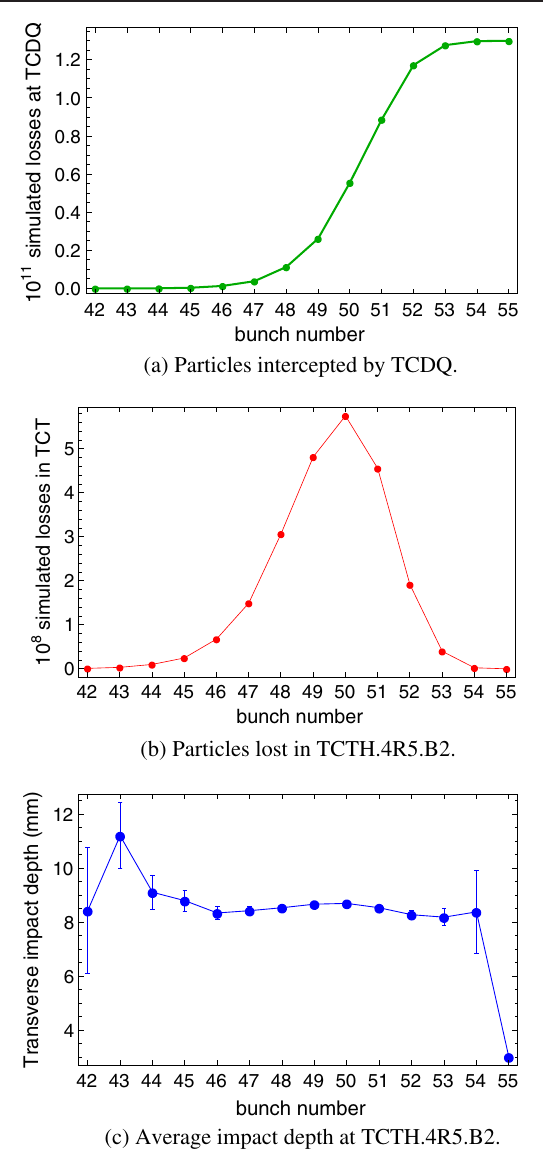
FIG. 6. Losses and impact parameter as a function of bunch number for Case 1. A bunch population of 1 . 3 × 10 11 p = b has been considered for the nominal LHC scenario to scale up the simulated losses on the TCT to a full physics beam.